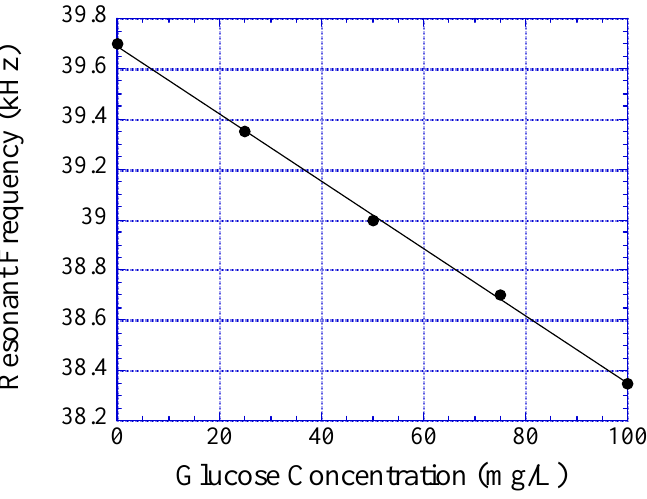
Figure 7. Shift in resonant frequency of a magnetoelastic sensor as a function of glucose concentrations. A ‘wet’ sensor is immersed in the glucose concentration of interest for sixty minutes to reach equilibrium prior to a